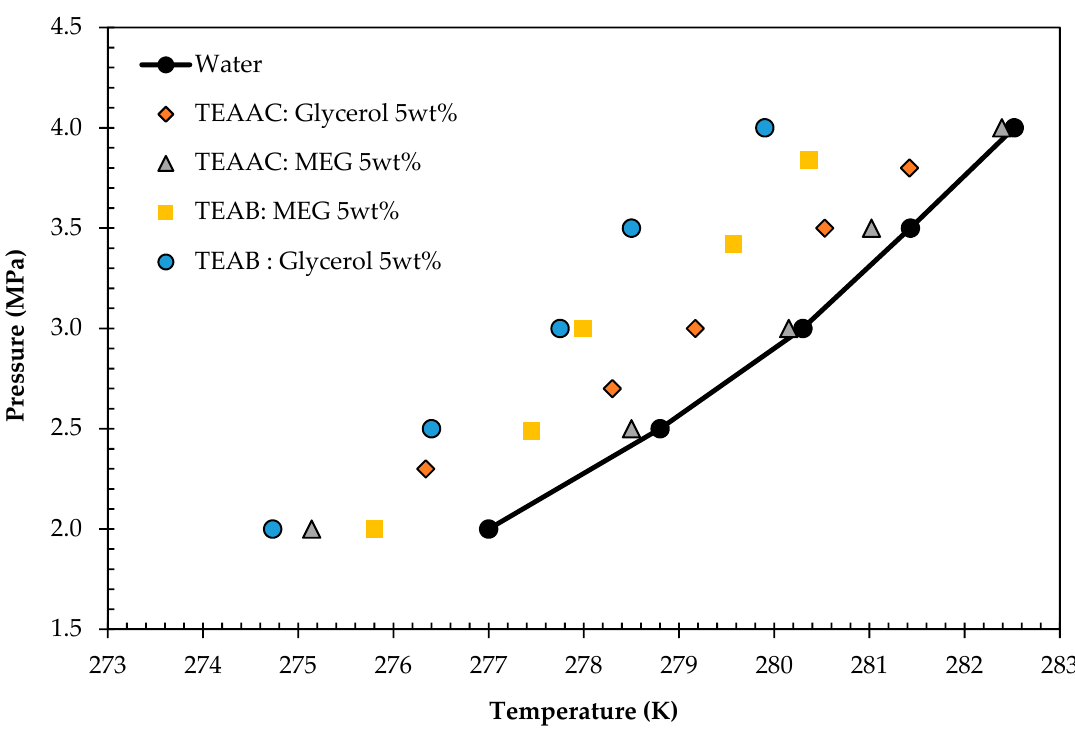
Figure 7. Hydrate Liquid-Vapor Equilibrium (HLVE) data of Deep Eutectic Solvent (DES) systems at 5 wt %